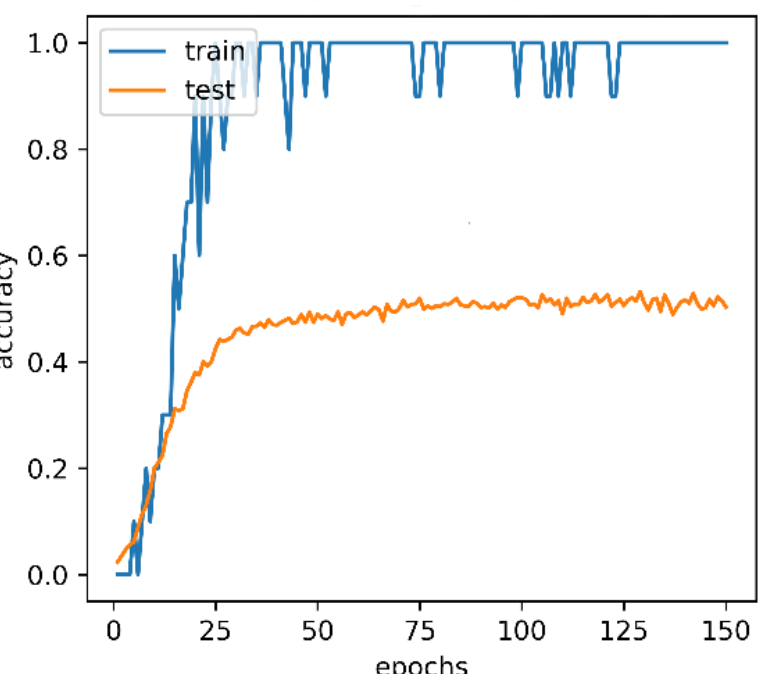
Figure 2. The training accuracy and the test accuracy of a CNN-LSTM model, which was implemented in nearly 3 days. The dataset is UCF101. The accuracy is an important metric on UCF101. The training accuracy is the result of the training data on the model. The test accuracy is the result of the test data on the model. The metric of accuracy is using image detection metrics by